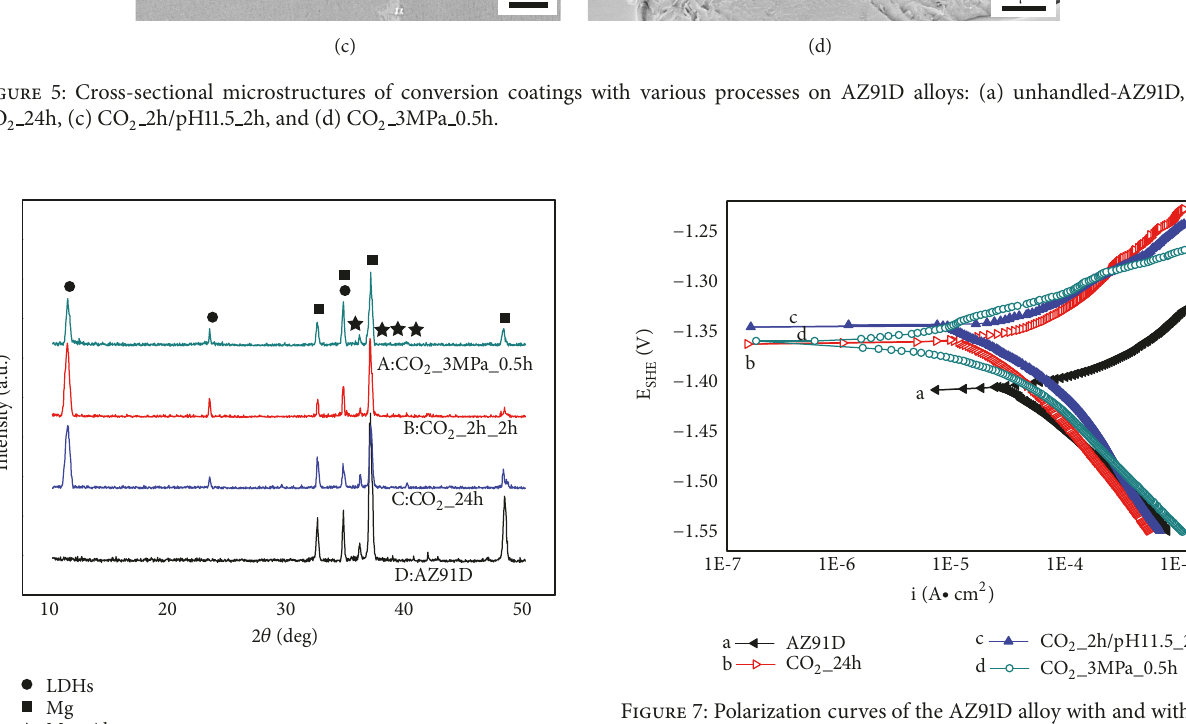
Figure 7: Polarization curves of the AZ91D alloy with and without conversion coating conversion coatings tested in 3.5wt.% NaCl